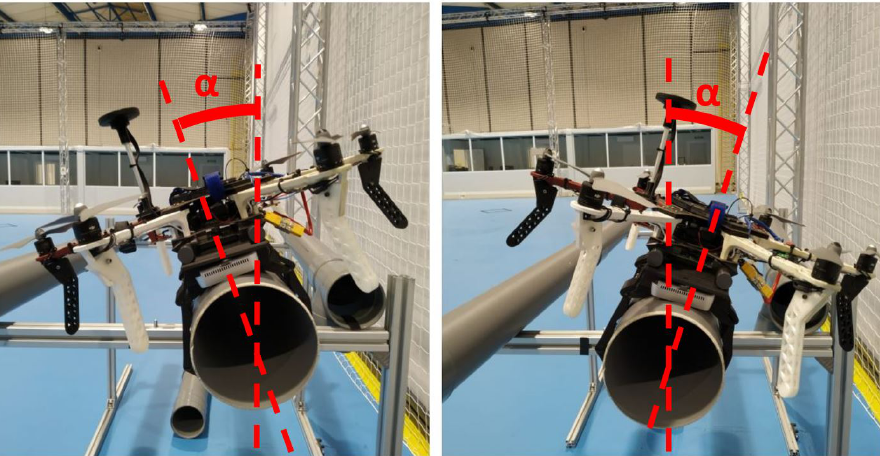
Figure 12. The maximum angle at which the landing gear can be grabbed with the drone on the